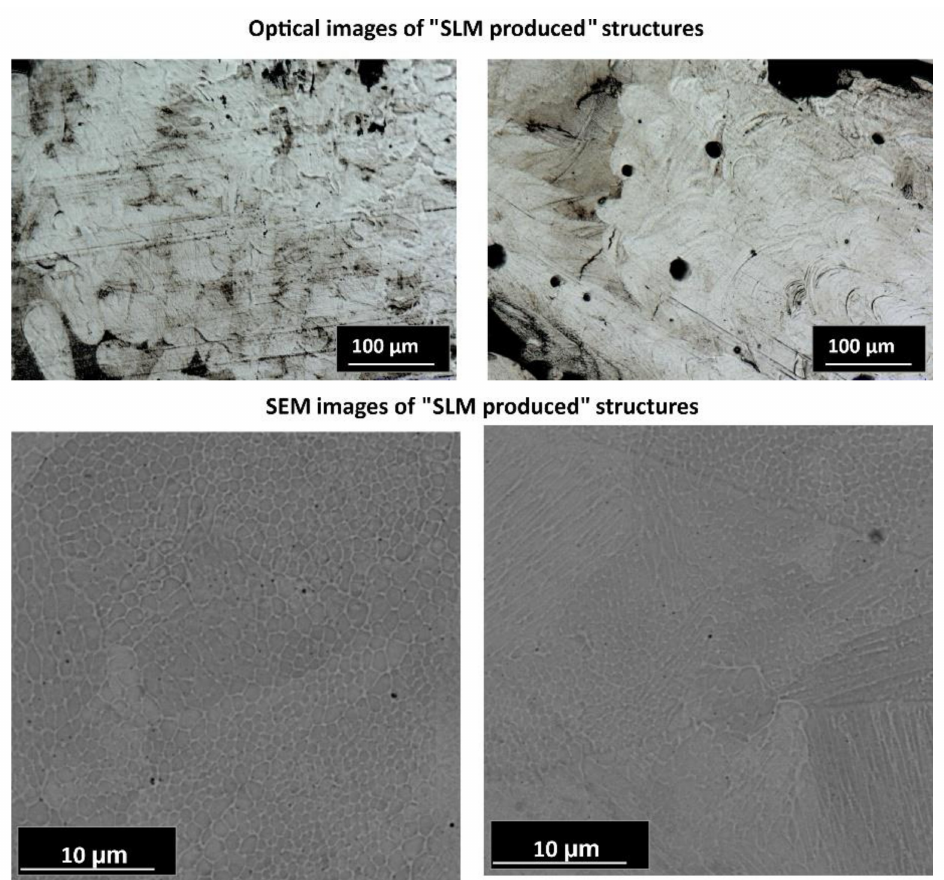
Figure 11. Digital and scanning electron microscope (SEM) images of the reference sample showing equiaxedausteniticgrainsaswellastheSLM-producedstructurerevealingthecharacteristicmorphology of laser-melted techniques.